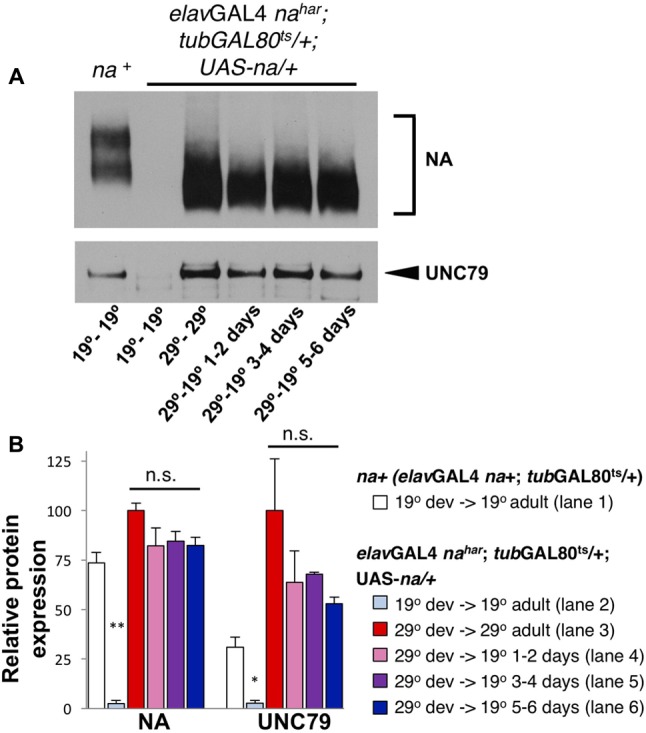
Transgenic NA protein produced during development persists into adulthood. Western blot analyses of NA and UNC79 expression from head extracts of Drosophila males raised at 19°C or 29°C and maintained at 19°C or 29°C as adults, as indicated. (A) Representative Western blot data. Lane 1 (na+): elavGAL4 na+; tubGAL80ts/ + males, raised and maintained at 19°C. Lanes 2–6: elavGAL4 nahar; tubGAL80ts/ +; UAS-na/+ males, with developmental (dev) and adult temperature conditions indicated below each lane (dev temperature – adult temperature). For NA (top blot), two bands are typically observed for the endogenous protein (lane 1) while transgenic UAS-na produces a single band of lower molecular weight (lanes 2–6) (Lear et al., 2005). (B) Quantitation of NA and UNC79 levels for genotypes and conditions in panel (A) (see key). Bars indicate normalized protein levels, as a percentage of levels observed in elavGAL4 nahar; tubGAL80ts/ +; UAS-na/+ flies in the 29°C development- 29°C adult condition (red bars; part A, lane 3). Error bars indicate standard error of the mean, as determined from two independent experiments. For elavGAL4 nahar; tubGAL80ts/ +; UAS-na/+ flies raised and maintained at 19°C (light blue bars; panel A, lane 2), asterisks denote significant differences from elavGAL4; tubGAL80ts/ + flies maintained in the same conditions (white bars, ∗p < 0.05, ∗∗p < 0.01; panel A, lane 1). For elavGAL4 nahar; tubGAL80ts/ +; UAS-na/+ flies raised at 29°C, adults were either maintained at 29°C (red bars; panel A, lane 3) or were shifted to 19°C for 1–2 days (pink bars; panel A, lane 4), 3–4 days (purple bars; panel A, lane 5), or 5–6 days (dark blue bars; panel A, lane 6). Protein levels in the 29°C to 19°C shifted conditions were not significantly different from the 29°C to 29°C control (n.s.; p > 0.08). Statistical comparisons were made using Student’s t-test.